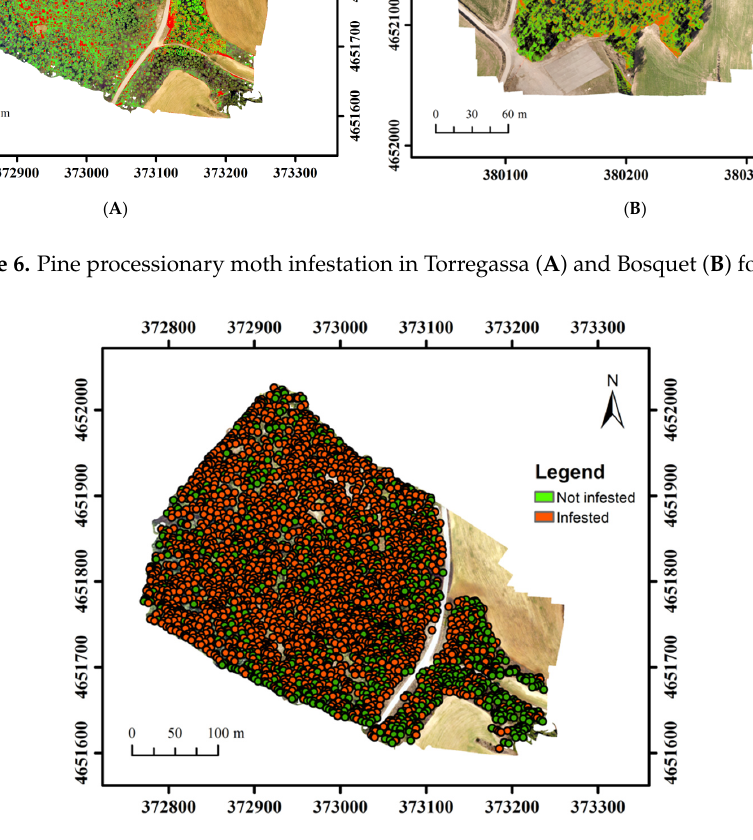
Figure 7. Automatic tree classification as infested or non-infested using RGB-UAS images for all trees automatically identified in the Torregassa forest site.